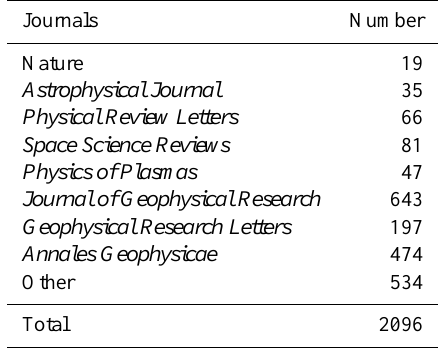
Table 2. Breakdown of Cluster and Double Star publications in par- ticular journals up to the end of